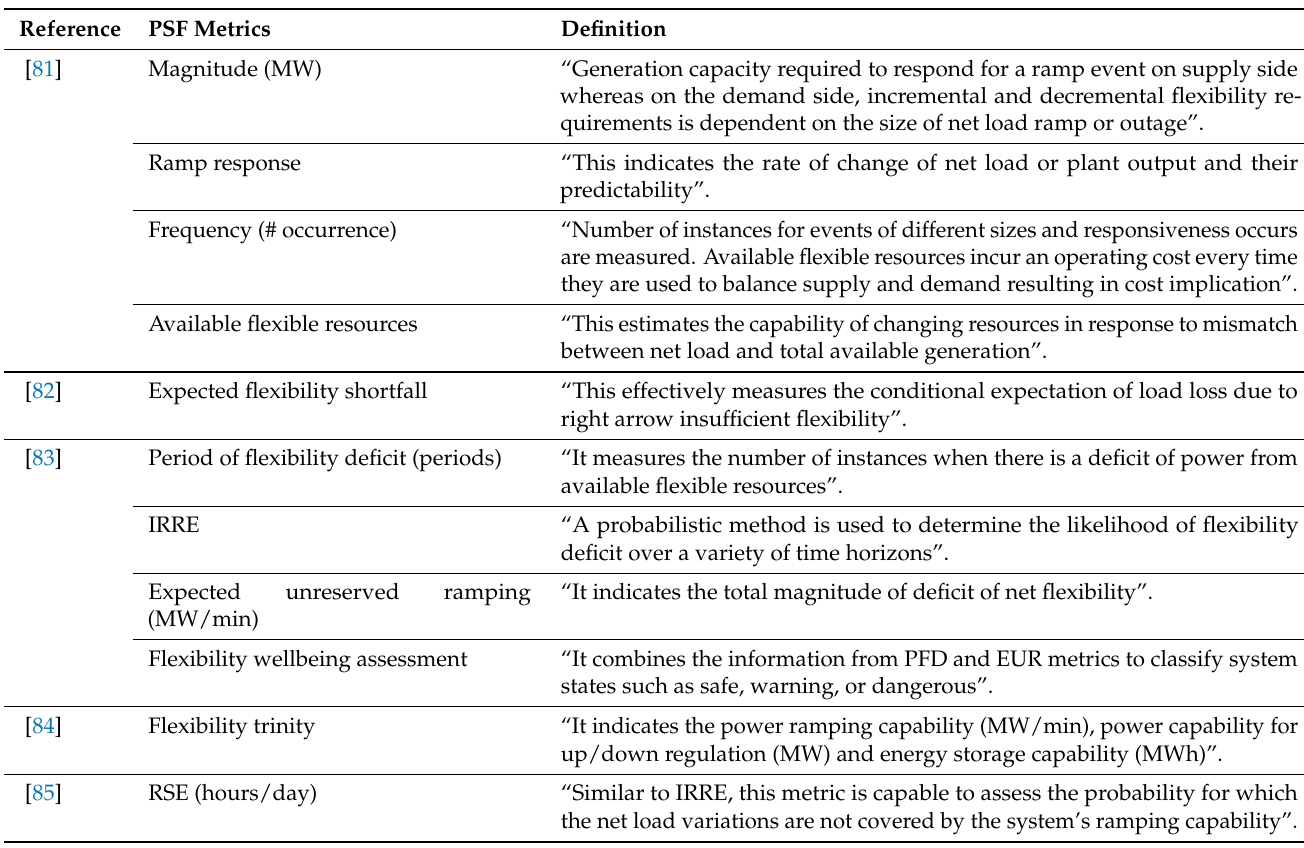
Table 7. Definitions of PSF